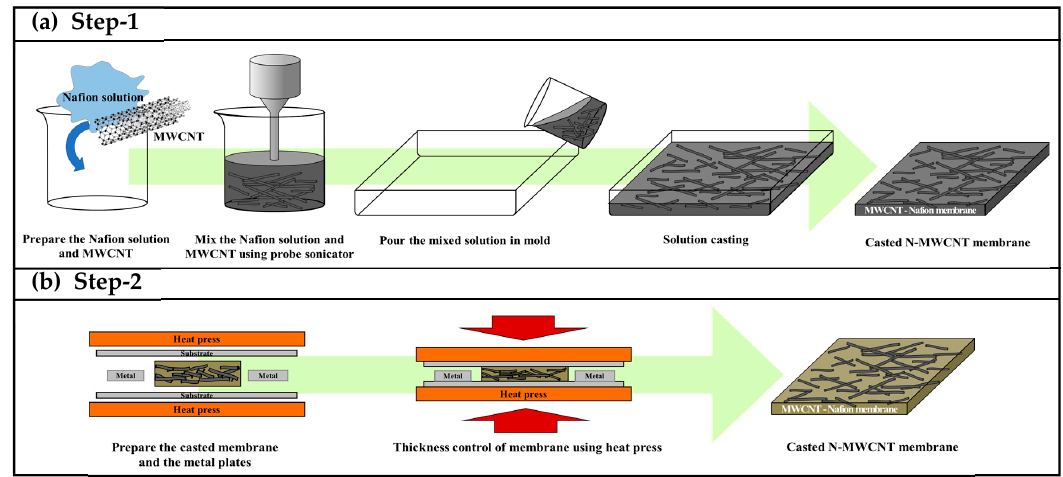
Figure 1. Schematics diagram of Nafion membranes with MWCNTs (N-MWCNT) membrane fabrication process by heat press two-step (HPTS) method ( a ) step-1 and ( b ) step-2.